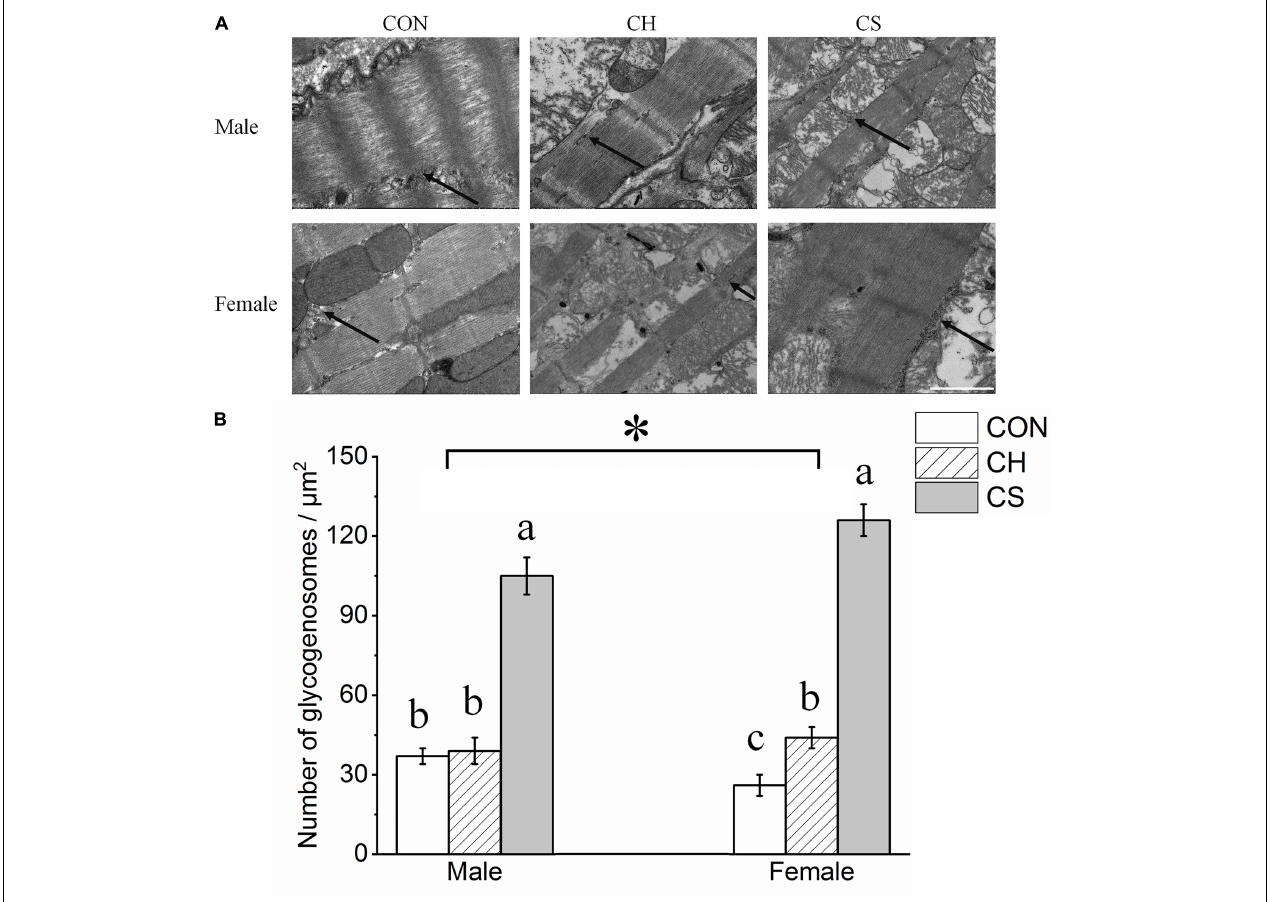
FIGURE 2 | Changes in number of myocardial glycogenosomes in Brandt’s voles. (A) Myocardial glycogenosomes in three treatment groups. Arrow indicates glycogenosome. Scale bar = 1 µ m. (B) Bar graph depicting changes in number of glycogenosomes. Values are mean ± SD. Six figures were analyzed in each sample; eight samples were analyzed in each group. CON, control group; CH, cool huddling group; CS, cool separated group. Different letters identify statistically significant differences among temperature treatment groups ( P < 0.05). * P < 0.05 significant differences between males and females.